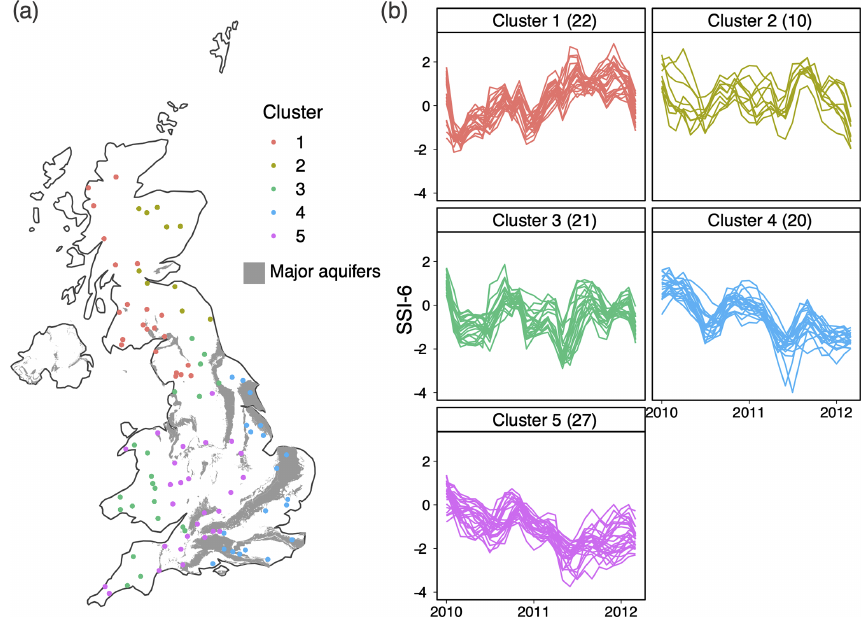
Figure 4. Hierarchical clustering of SSI-6 during the 2010–2012 drought event. (a) Spatial variation in the five identified clusters. (b) SSI-6 between January 2010 and December 2012 for the catchments in each cluster (with the number of catchments